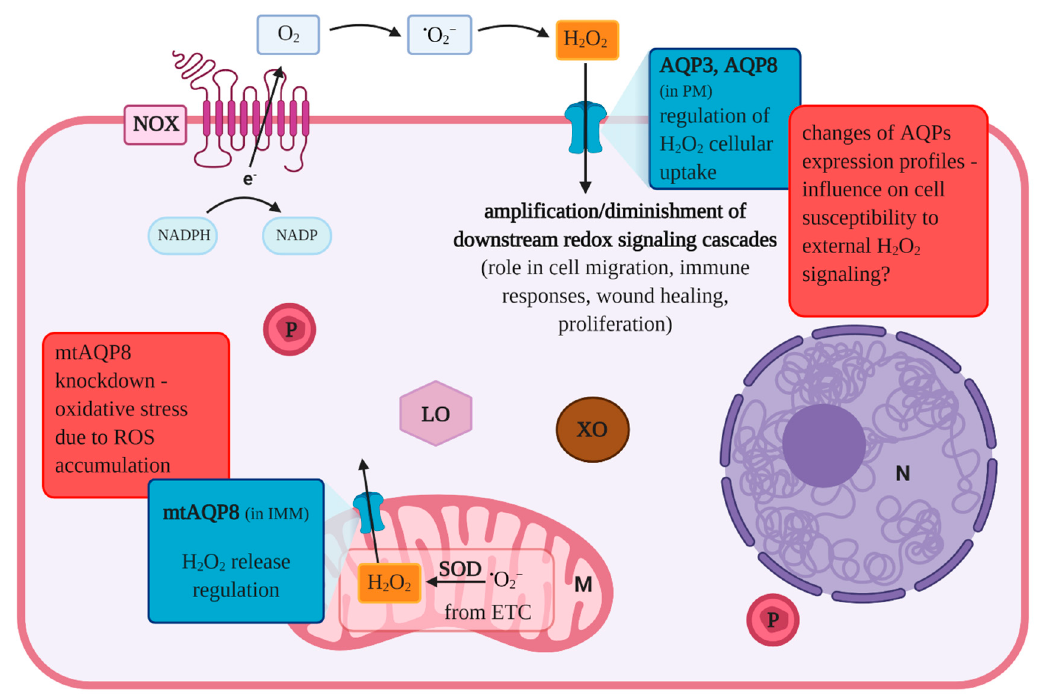
Figure 1. Schematic illustration of the cellular location of aquaporins and related proteins. ( a ) shows the localization and function of aquaporins and related proteins; ( b ) shows the localization of aquaporin and related proteins in the oocyte-cumulus-complex. Abbreviations: AQP—aquaporin; Cx—Connexin; CFTR—Cystic Fibrosis Transmembrane Conductance Regulator; Panx—Panexin;